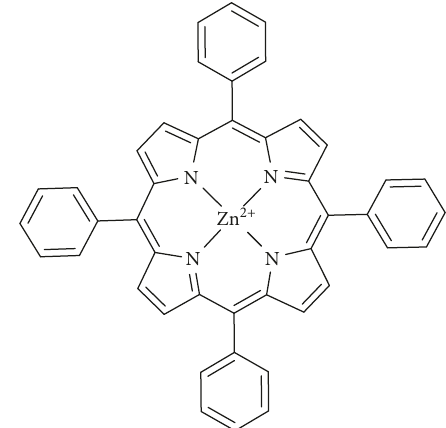
Figure 7: The structure of